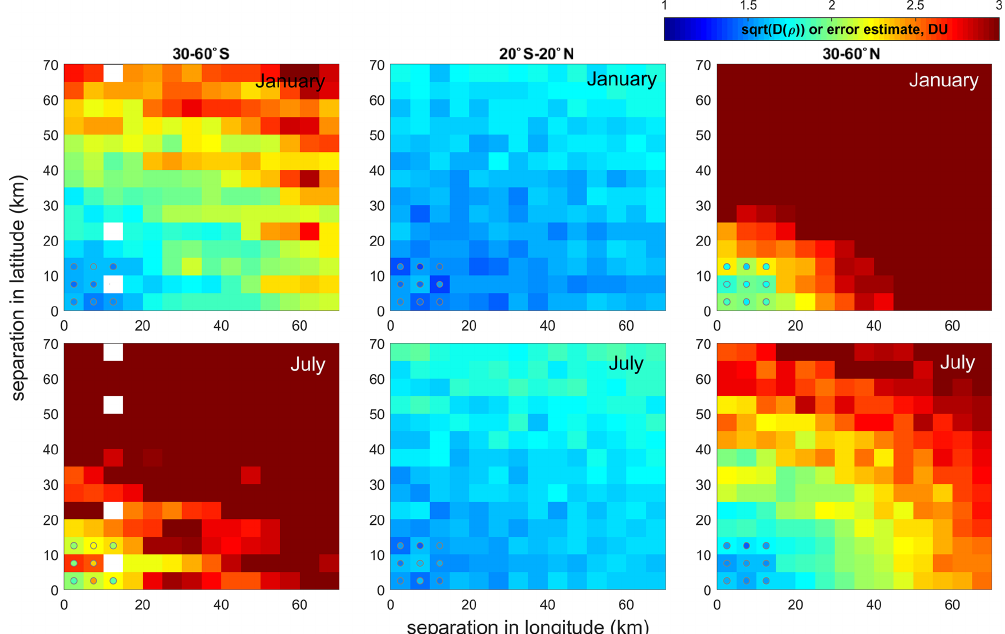
Figure 5. Structure function (in DU) for different latitude bands (columns) and months (rows), with the focus on small separations. Colored circles at the origin indicate the uncertainty estimates (ex ante) given by the inversion